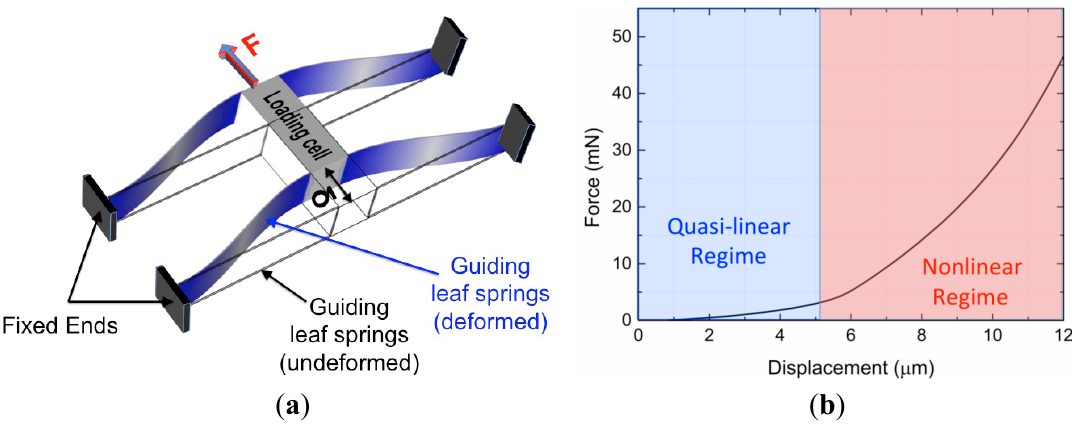
Figure 5. ( a ) Mechanical guidance principle of the loading cell. ( b ) The characteristic force-deformation curve of the guidance which consists of four parallel leaf-springs is shown here. The parameters ( w = 100 µ m, l = 5000 µ m and t = 230 µ m) chosen for this graph correspond to the parameters of the fabricated device. Here, the guidance is used in its quasi-linear regime.